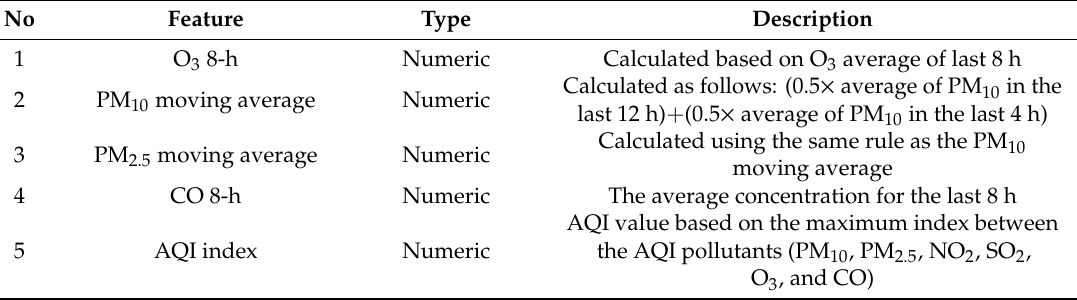
Table 1. Other features added to the prediction model.